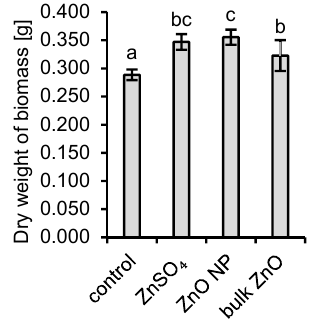
Figure 3. The dry weight of biomass of Aspergillus niger after the experiment; a, b and c represent the statistically similar means between different groups at α = 0.05 (two-tail t -test).